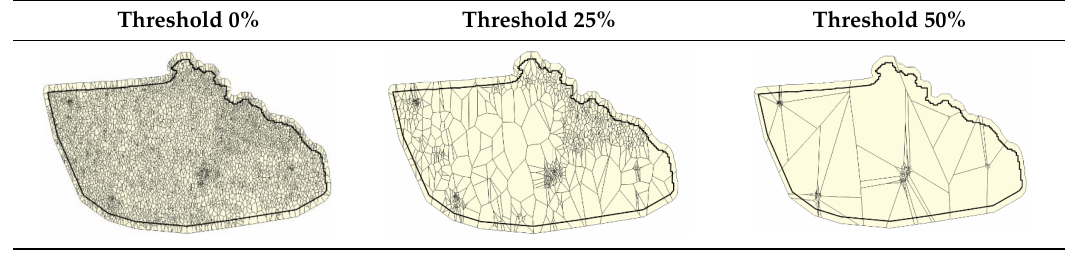
Table 4. Visualizations of the generated Voronoi polygons depending on the threshold coe ffi cient